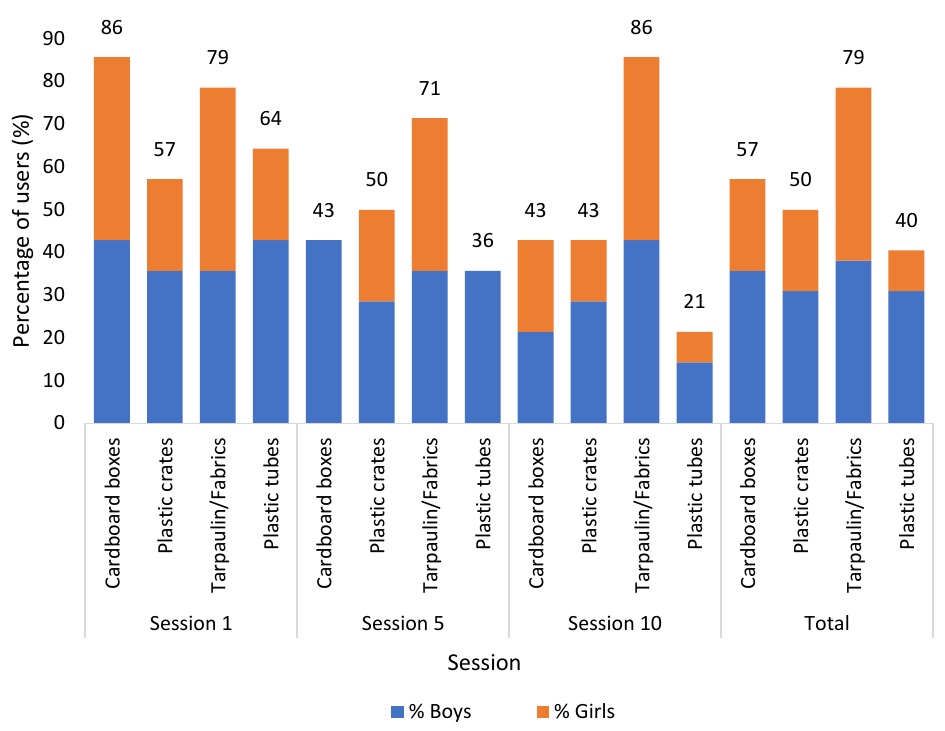
Figure 4. Percentage and sex of users per material, by session and in the total of the three sessions. The cardboard boxes were the material used by the most children in Session 1